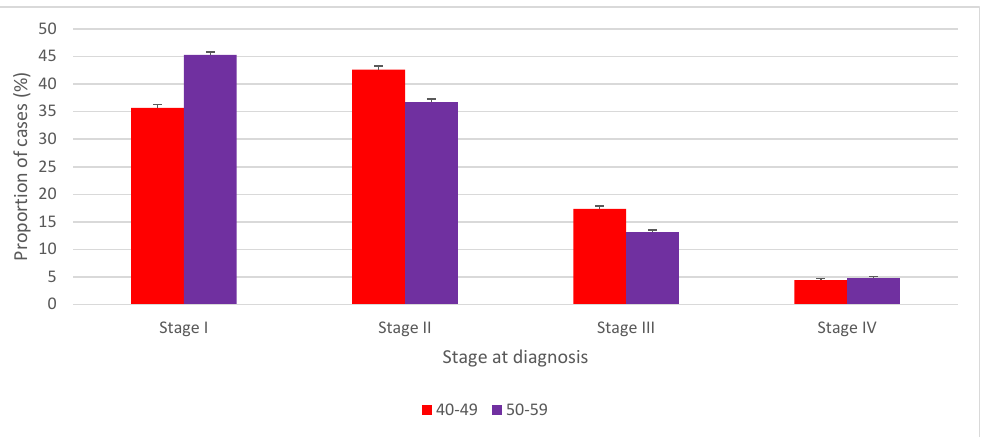
Figure 2. Stage – specific distribution of female breast cancer cases by age group at diagnosis, Canada excluding Quebec, 2010 to 2017 period. Note: Quebec is excluded because cases diagnosed in Que- bec from 2011 onward had not been submitted to the Canadian Cancer Registry. The ages between the dashed lines represent those age groups for which mammogram screening is currently recom- mended. Source: Canadian Cancer Registry (1992 to 2018) at Statistics Canada [42].